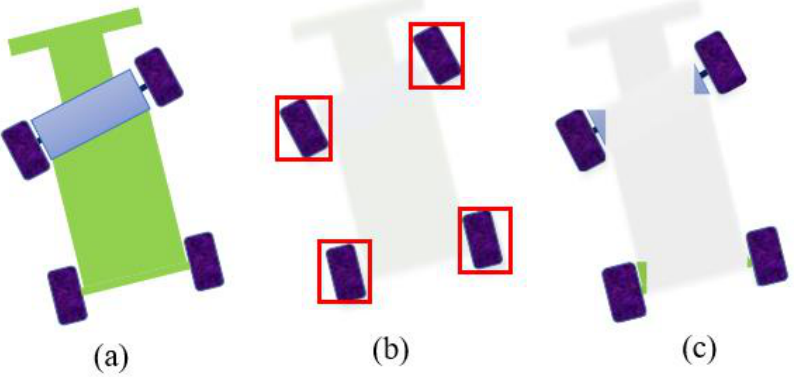
Figure 11. Schematic diagram of the turning vehicle,:( a ) a top-down view of the vehicle, ( b ) locating the wheels, and ( c ) obtaining the wheels’ outl ine.